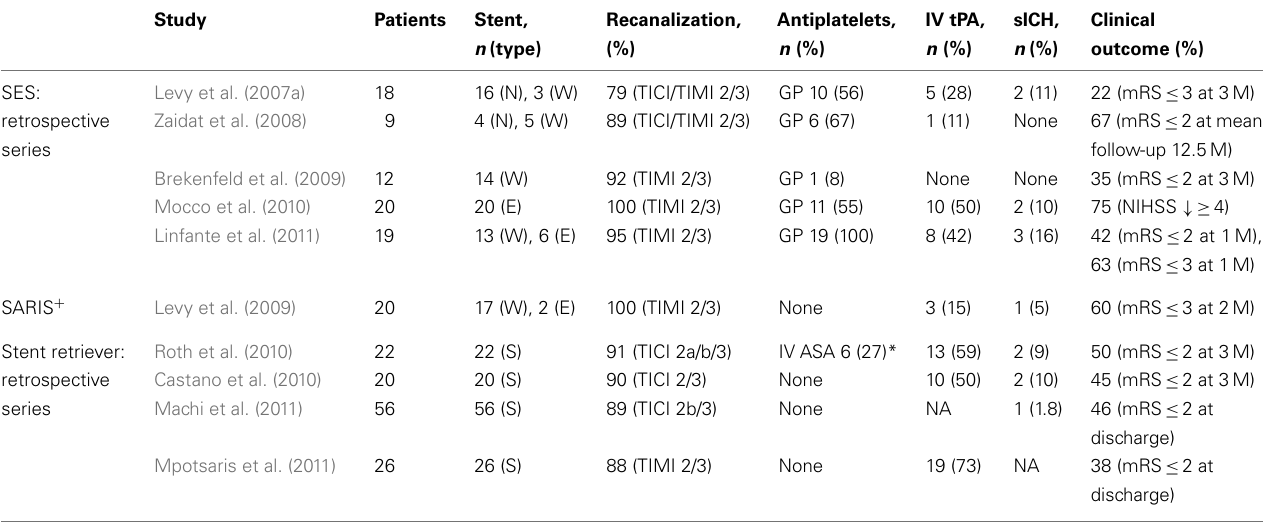
Table 1 | Larger series with self-expandable stents in the treatment of acute ischemic